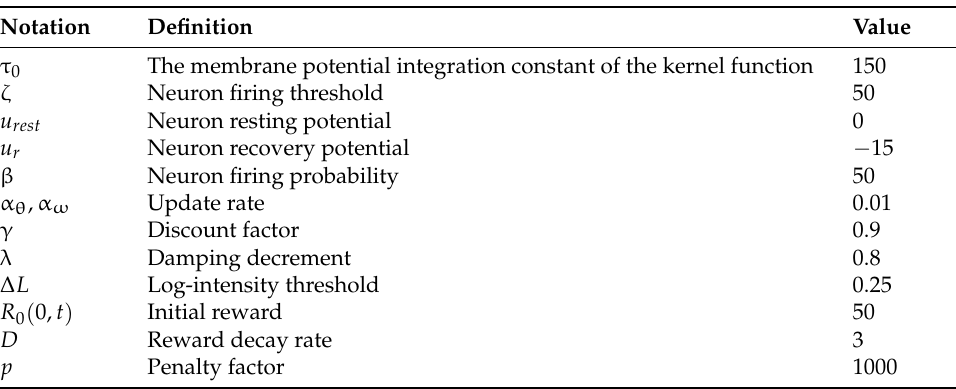
Table 1. Summary of parameters.